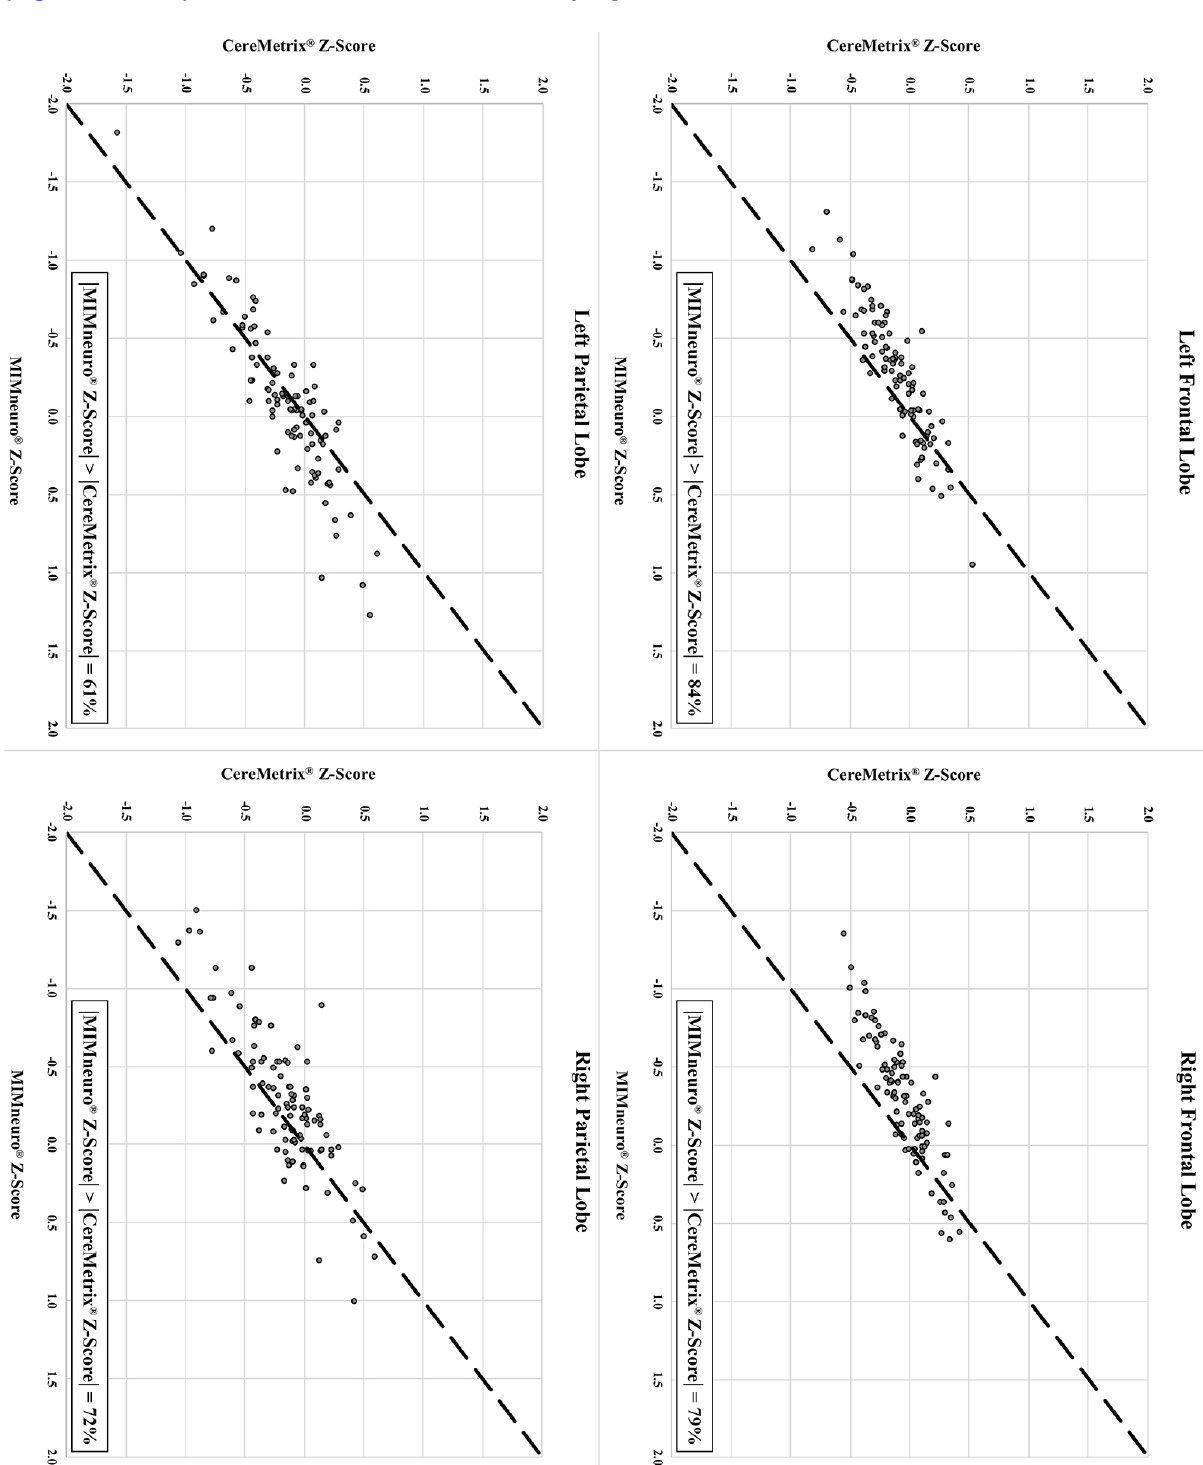
Figure 5. Frontal and parietal lobe equality plots between CereMetrix ® and MIMneuro ® data showing their scatter around the line of equality. The proportion of measurements where MIMneuro ® ’s z-score magnitude was greater than the corresponding CereMetrix ® z-score magnitude is also